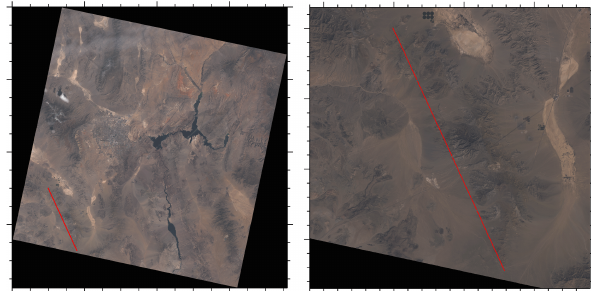
Figure 5. Landsat 8 OLI scene of southern Nevada captured on 31 March 2014 at 18:16UTC is shown on the left. The ER-2 flight path and associated RSP and AVIRIS measurements were collected along the red line during 18:13–18:17UTC on the same day. The flight path is 24.7 ◦ west of north with total path length of 57.1km. The right image is a magnified view of the area of the flight line.